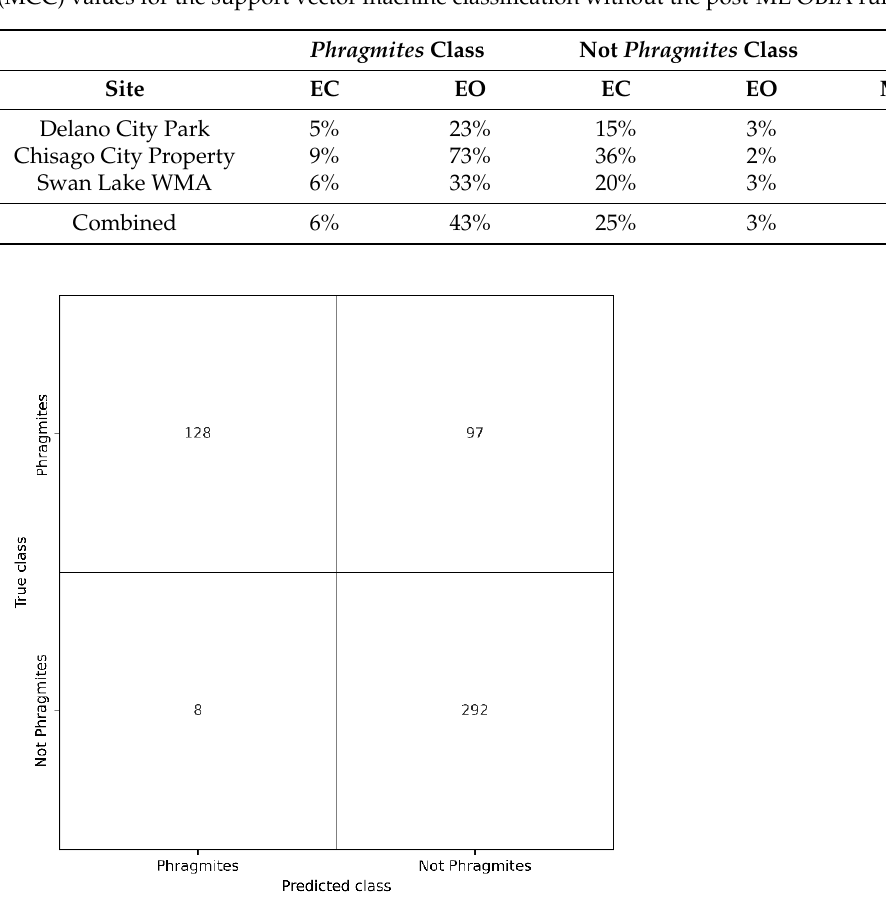
Table 19. Errors of commission (EC), errors of omission (EO), and Matthews correlation coefficient (MCC) values for the support vector machine classification without the post-ML OBIA rule set.